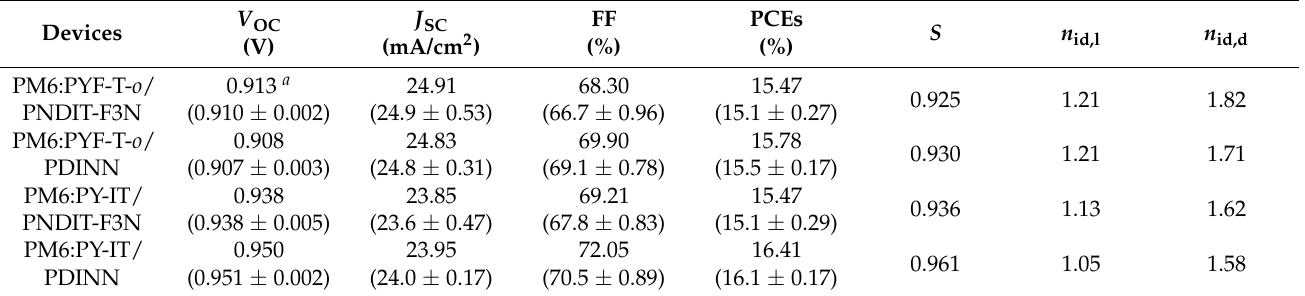
Figure 3. ( a ) UV-Vis transmittance spectra of PNDIT-F3N and PDINN. ( b ) UV-Vis absorption spec- tra of PNDIT-F3N and PDINN. ( c , d ) Absorption spectra of the active layers based on PYF-T- o and PY-IT, respectively.